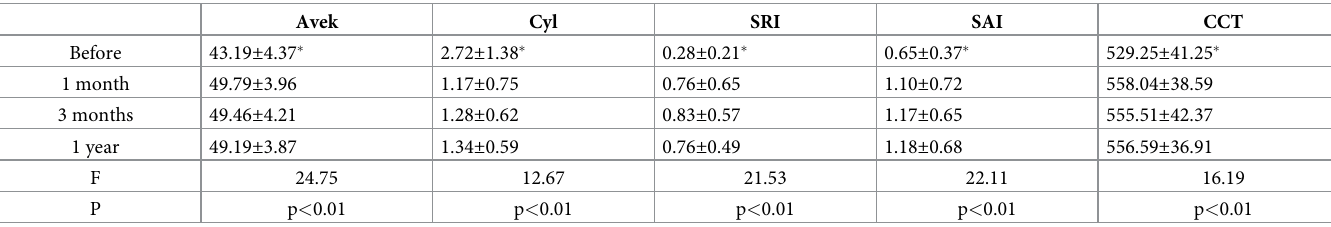
Table 2. Corneal topography and CCT before and after surgery. Avek Cyl SRI SAI